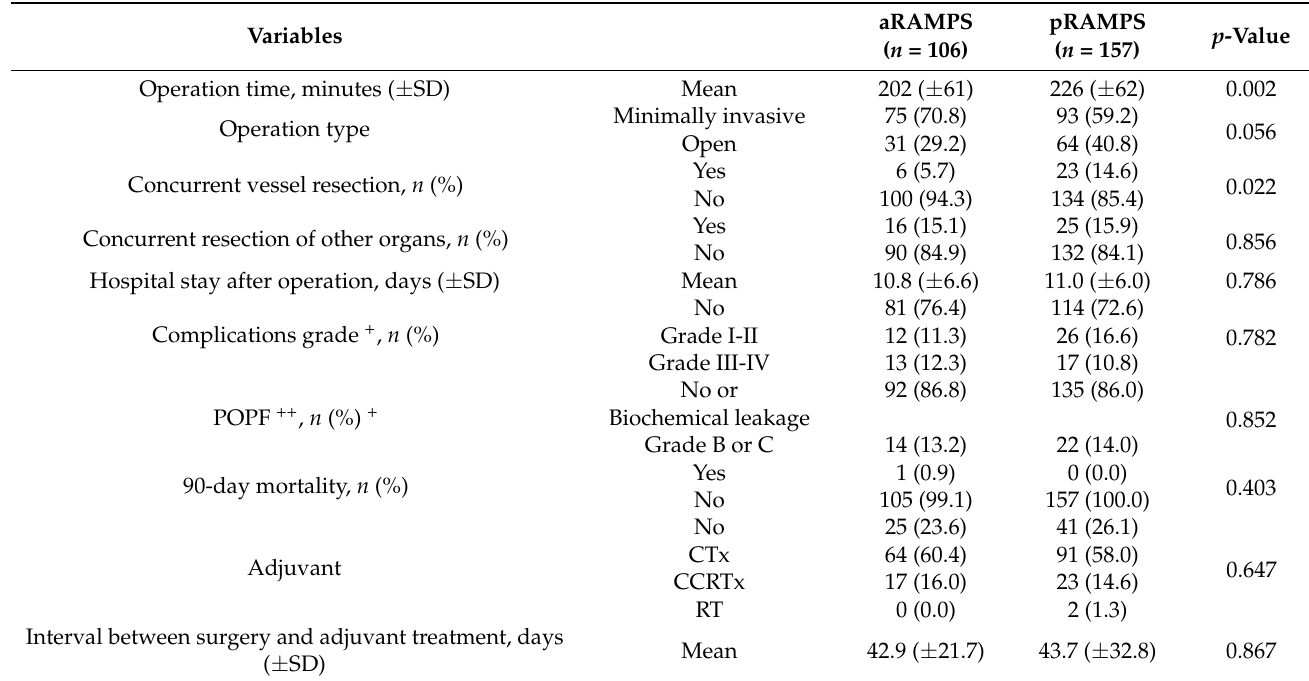
Table 5. Perioperative outcomes of radical antegrade modular pancreatosplenectomies among patients without periadrenal